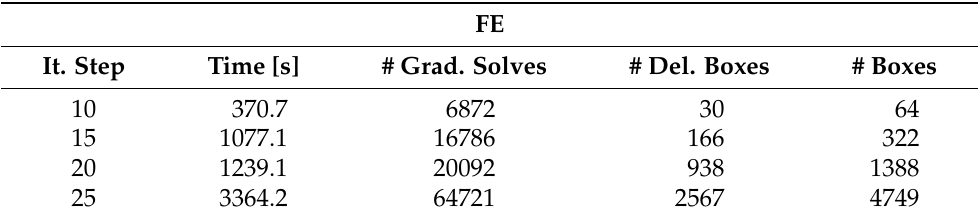
Table 1. The performance of the subdivision algorithm with the FE-solver and the steepest descent method.